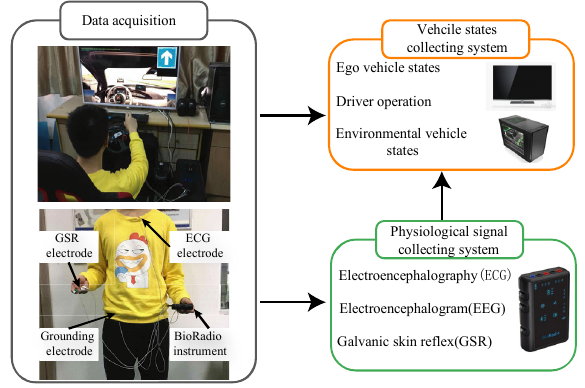
Figure 2. Data collection system architecture.